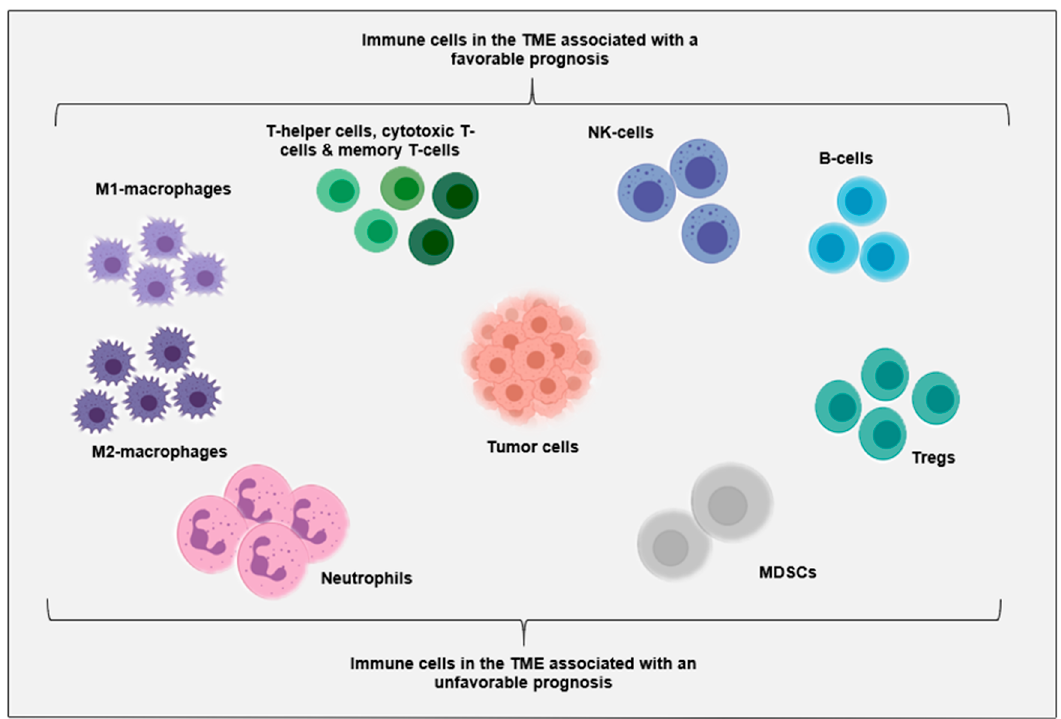
Figure 1. Overview of prognostically relevant immune cell populations in the tumor microenvironment as described in solid malignancies. MDSCs: myeloid-derived suppressor cells; NK: natural killer; Tregs: regulatory T-cells. For a detailed overview of relevant receptors, ligands and expression states of these immune cell populations in AML, we refer the reader to two excellent reviews [4,5].